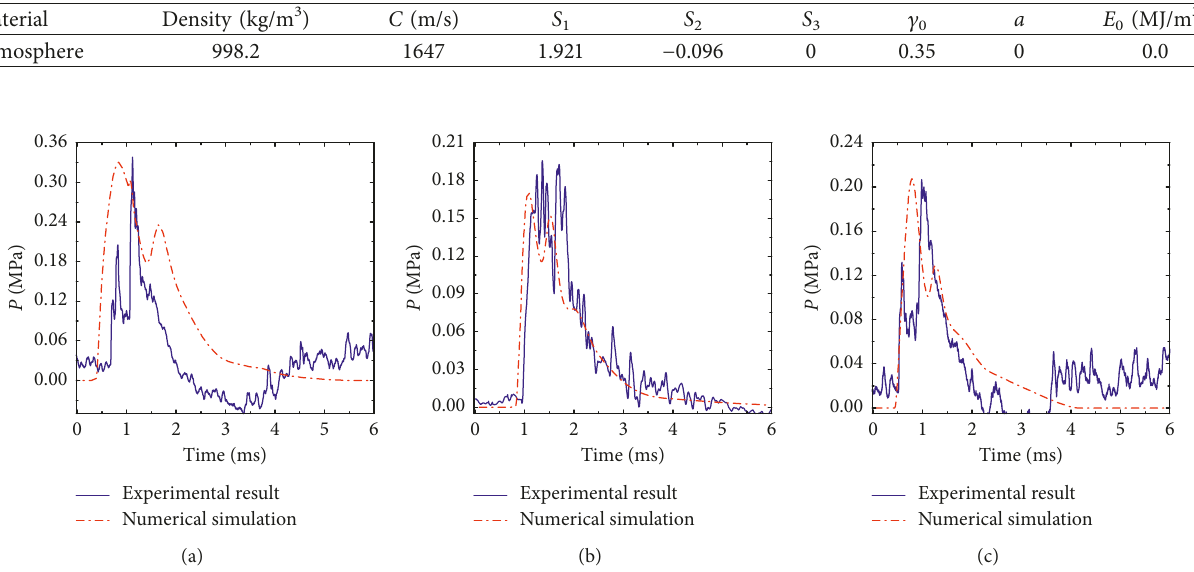
Table 4: Material parameters of water in numerical simulation.